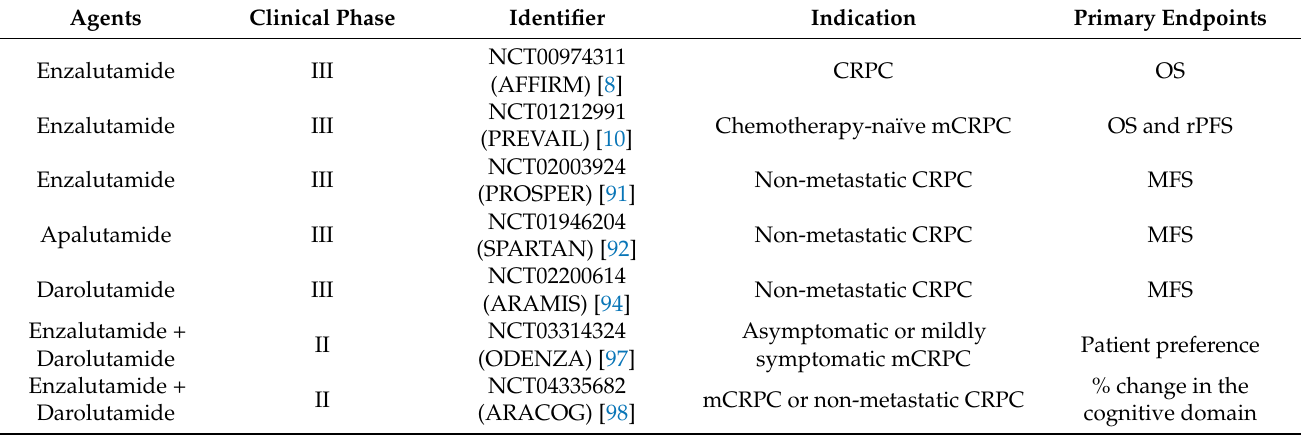
Table 1. Clinical trials evaluating androgen receptor inhibitor therapy for non-metastatic